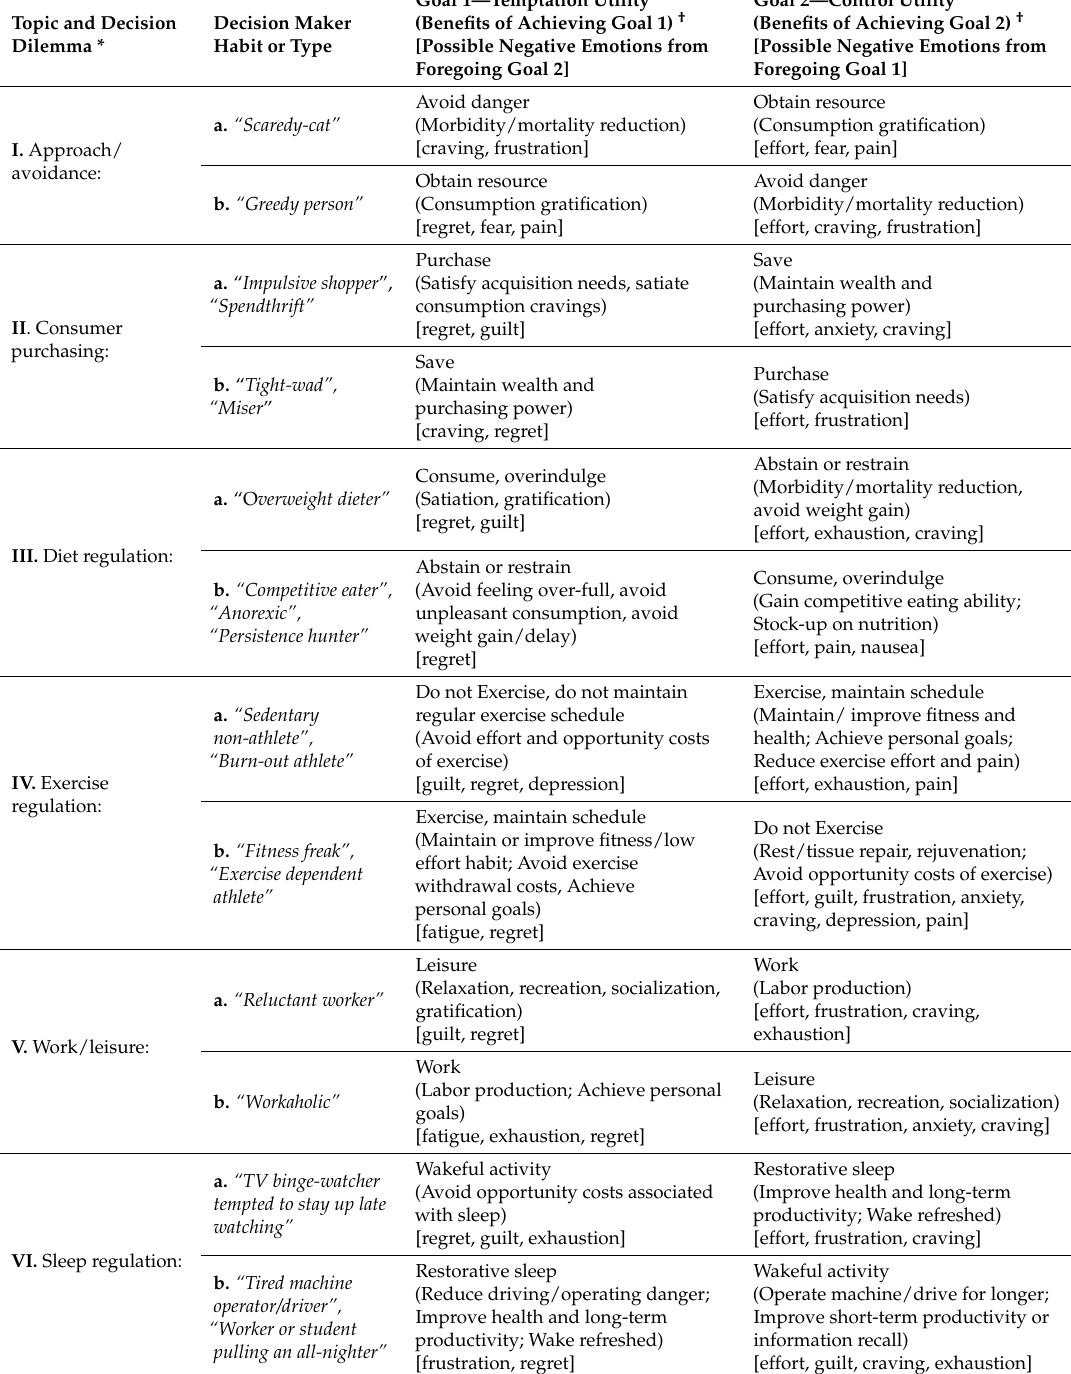
Table 1. Decision dilemmas, conflicting goals, benefits and possible negative emotional consequences of differential goal